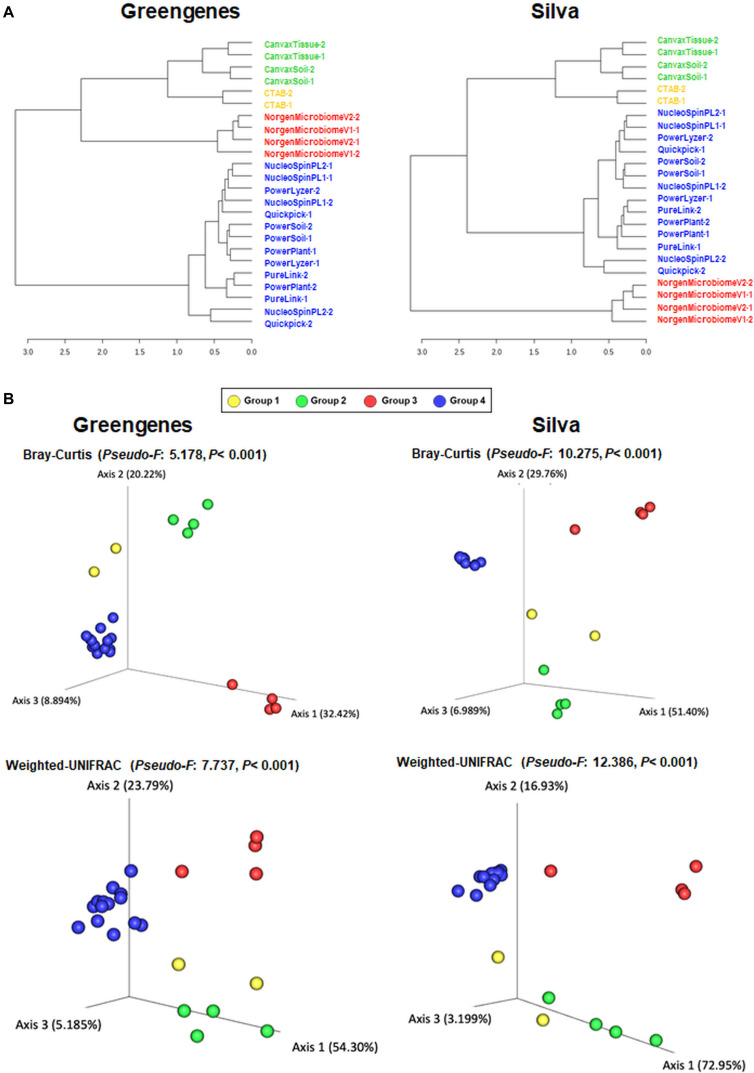
Hierarchical clustering dendrogram analysis using Ward method and Bray–Curtis distance (A) And principal coordinate analysis (PCoA) of weighted UniFrac and Bray–Curtis distances (B) Of olive xylem bacterial communities obtained by using different DNA extraction kits and after taxonomic assignments with the Greengenes_13-8 and Silva_132 databases. Colored dots represent the four clusters obtained in the hierarchical clustering analysis. PERMANOVA (999 permutations; P < 0.05) was performed to test significant differences according to DNA extraction kits.